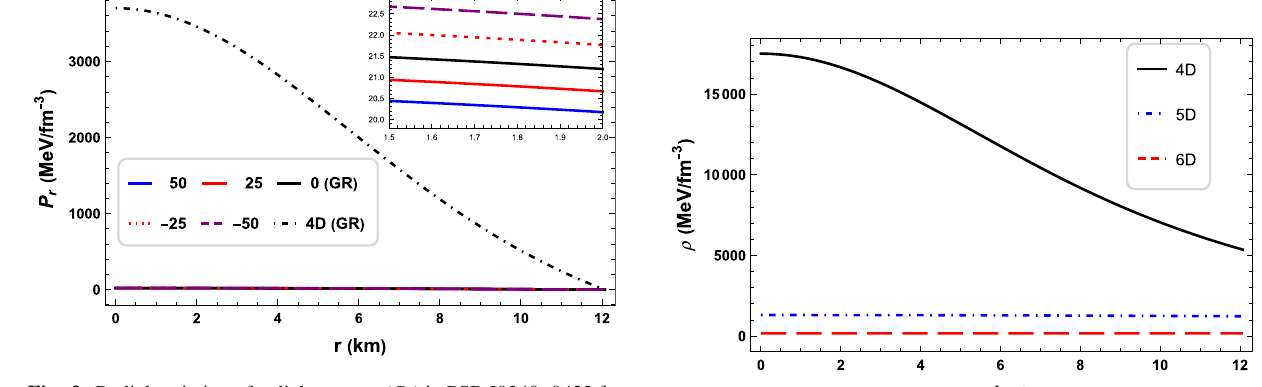
Fig. 2 Radial variation of radial pressure ( P r ) in PSR J0348+0432 for different α values in 5D with α = 0 in 4D